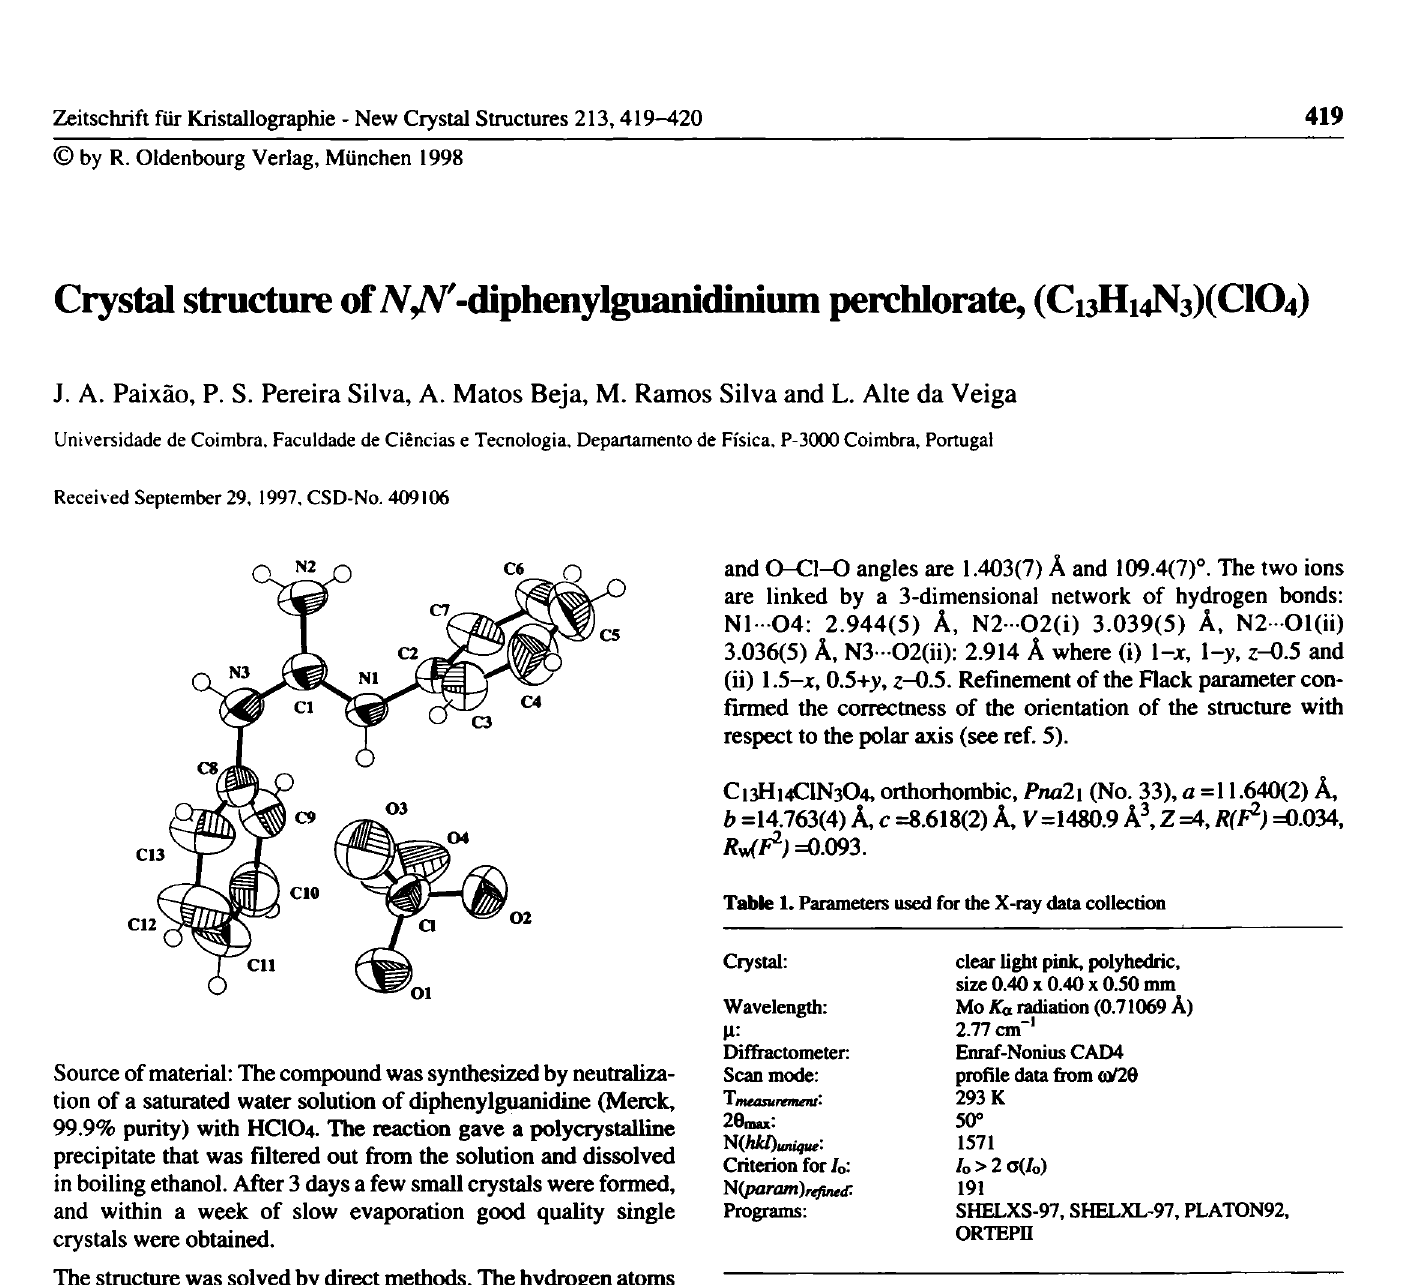
Table 2. Final atomic coordinates and displacement parameters (in A^) Atom